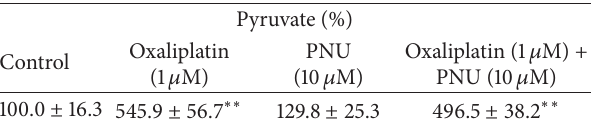
Table 1: Astrocyte monoculture. Pyruvate intracellular levels.